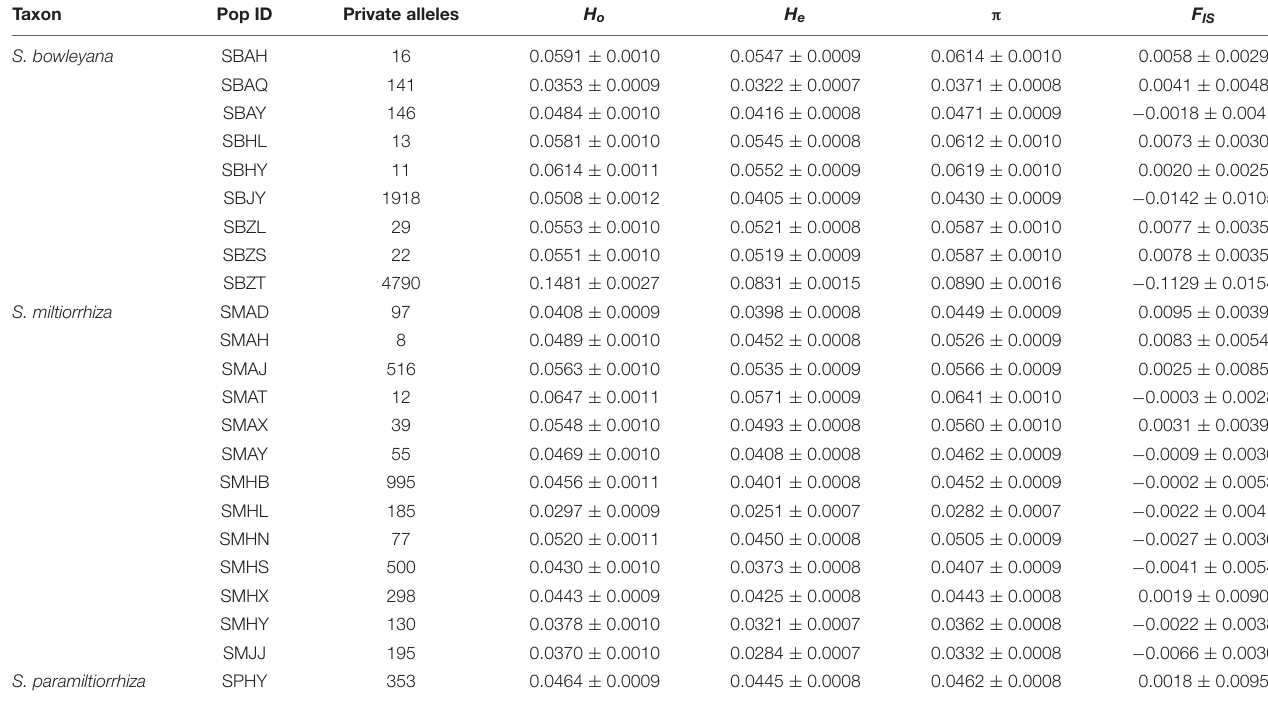
TABLE 1 | Population genetic statistics of S. miltiorrhiza , S. bowleyana , and S. paramiltiorrhiza in this study: observed heterozygosity ( H o ), expected heterozygosity ( H e ), genetic diversity ( π ), inbreeding coefficients ( F IS ). Taxon Pop